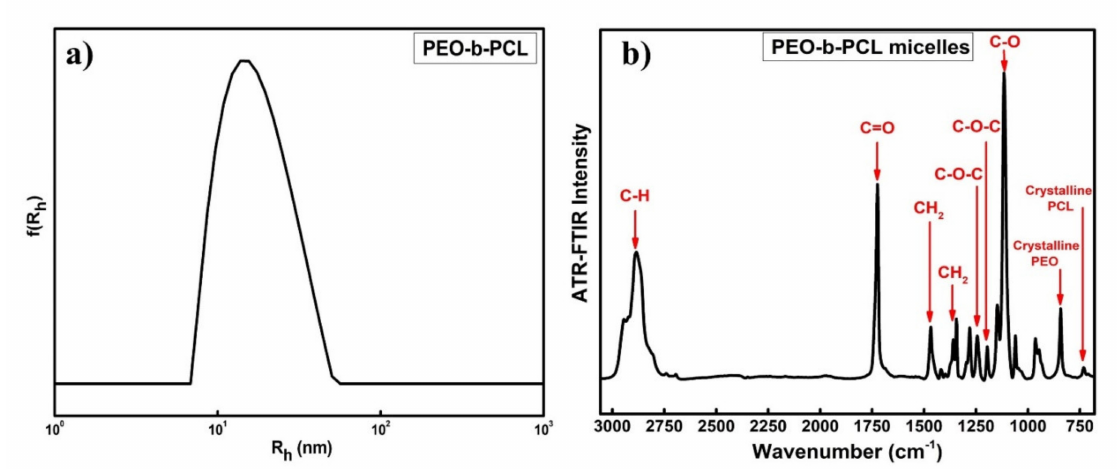
Figure 1. ( a ) Size distribution from Contin for the PEO-b-PCL diblock at 90 ◦ in aqueous solutions using the organic solvent evaporation method, ( b ) attenuated total reflection Fourier transform (ATR-FTIR) spectra of PEO-b-PCL micelles in aqueous solutions using the